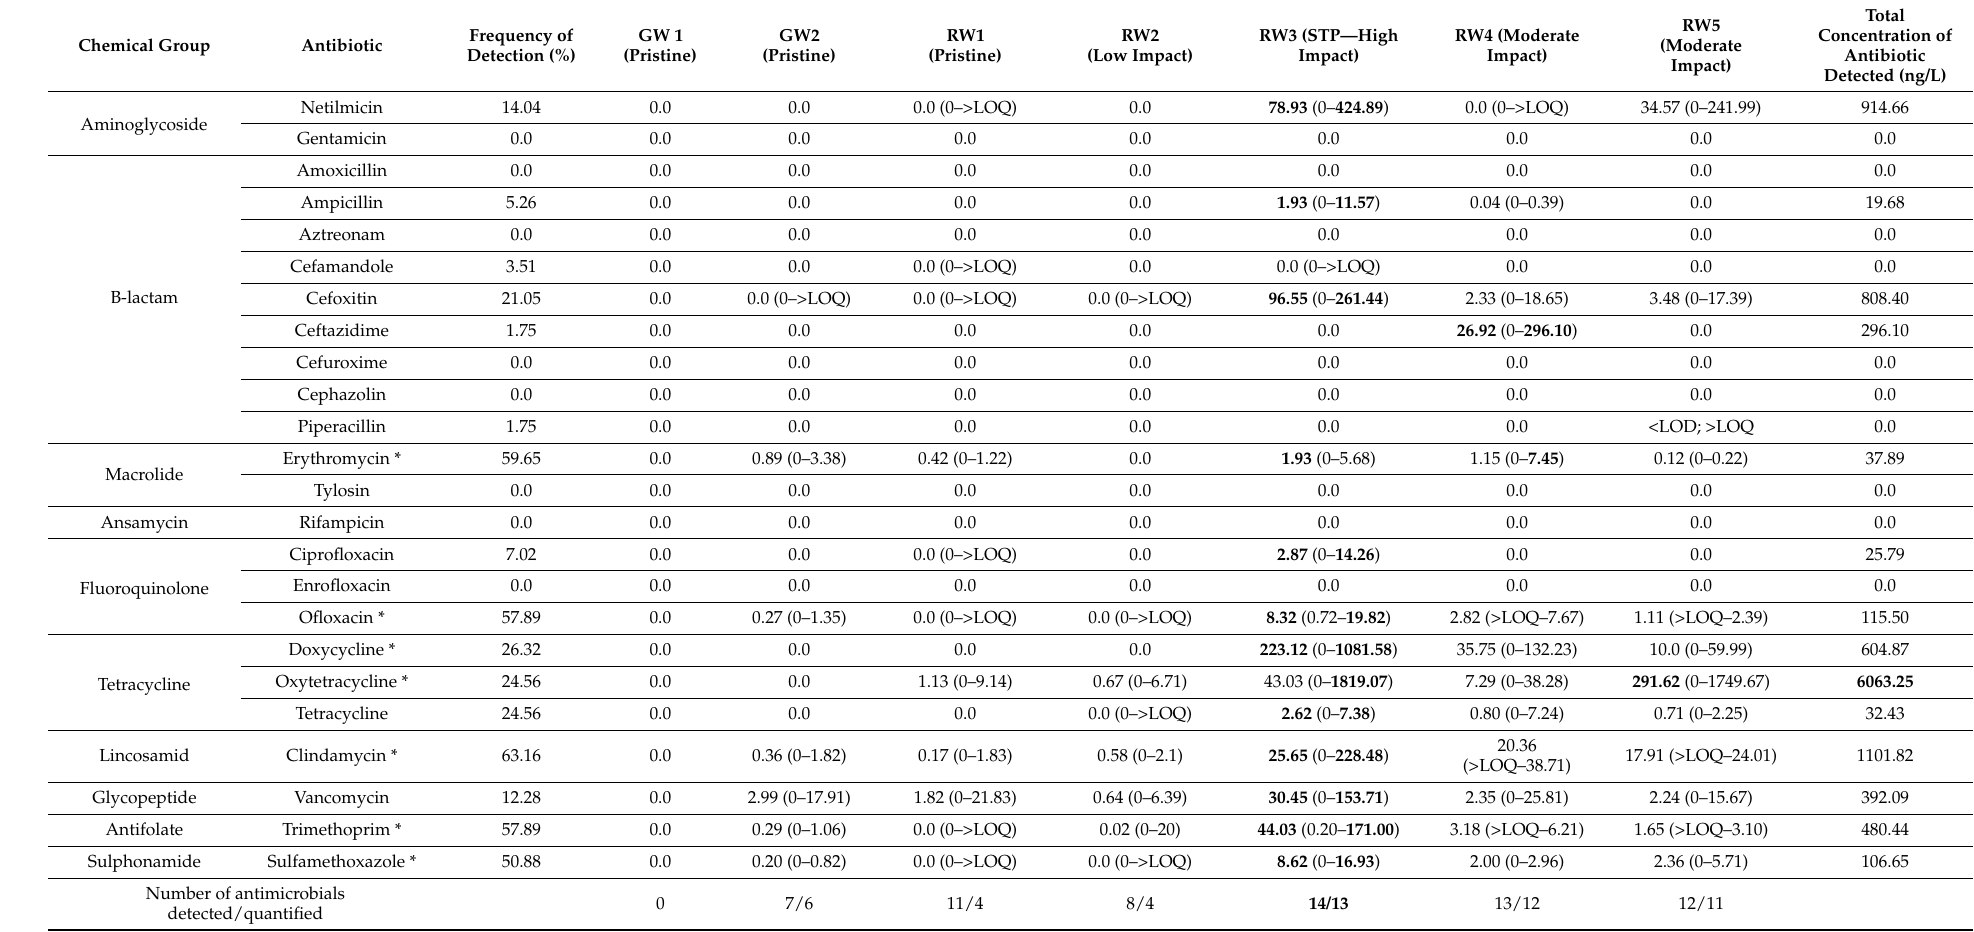
Table 1. Overall frequency of antibiotic detection (%) and concentrations of antimicrobial agents in the examined groundwater (GW) and river water (RW) samples. The values are presented as means of all measurements, values in brackets are min–max. The highest values of mean and max. concentrations, as well as the number and frequency of antimicrobials detected, are shown in bold. The concentration of antimicrobial agents marked with an * differ significantly between the examined sites ( p <